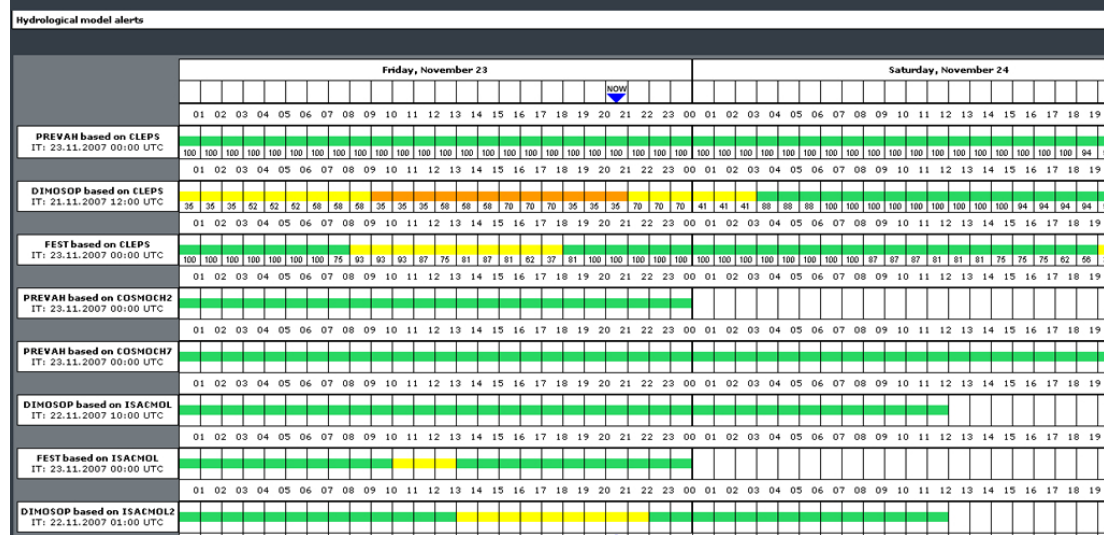
Fig. 2. Screenshot of the D-PHASE VP for 23 Novemebr 2007, level 3 (hydrological basin) for the Toce at Candoglia River, in Italy. Each of the eight lines line corresponds to a hydrological prediction chain, results from the combination of one of the three hydrological models implemented for that basin (PREVAH, DIMOSOP and FEST) forced by a meteorological prediction either in ensemble (COSMO-LEPS) or deterministic mode (COSMOCH2, COSMOCH7, ISACMOL, ISACMOL2). Green, yellow, orange (and red – not in this warning) colors correspond to the defined hydrometric warning levels. For the top three probabilistic predictions the percentage of hydrographs members with peaks in the respective warning level range is